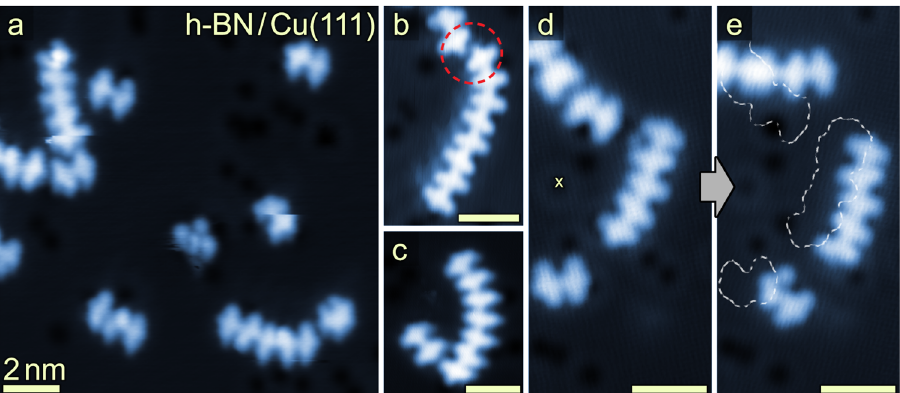
Fig. 5 Oligomerization on h-BN/Cu(111) after deposition of 1 onto the surface held at 500 K. a STM overview image shows coupled molecular units, analogous to the cycloaddition products observed on Au(111) and Ag(111). Unidenti fi ed species are also observed, cf. image ’ s center and Table 1. b , c Close- up STM images reveal the formation of chains of up to eight monomer units. Non-covalent aggregation with antiparallel alignment of the – CN dipoles of a dimer and an octamer is marked by a red dashed circle in b . d STM image of oligomer chains. e After application of a voltage pulse ( V S = − 2.5 V, I = 100 pA, t = 1 s) at the position marked with a yellow cross in d a shift of the positions of the chains is observed. The chains remain intact and each chain is shifted as a whole. The positions of the chains before the voltage pulse are marked with white dashed traces (data in a , c – e recorded after post-annealing the sample to 580 K). Scan parameters: ( a ) V S = 1.10 V, I = 50 pA, ( b ) V S = 0.66 V, I = 60 pA, ( c ) V S = 1.0 V, I = 50 pA; ( d ), ( e ) V S = 1.7 V, I = 24